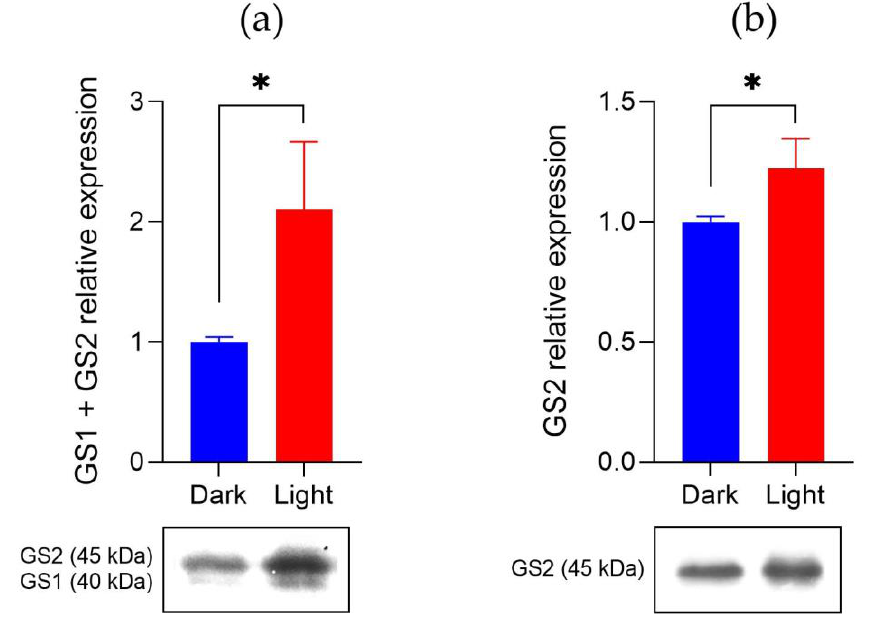
Figure 3. Glutamine synthetase (GS) protein abundance is higher in the light compared to dark incubated plants. Western blot protein expression analysis for both GS1 and GS2 ( a ) and for GS2 ( b ), the chloroplastic isoform of GS. Asterisks indicate significant differences by t-test ( p < 0.05) between light versus dark conditions.